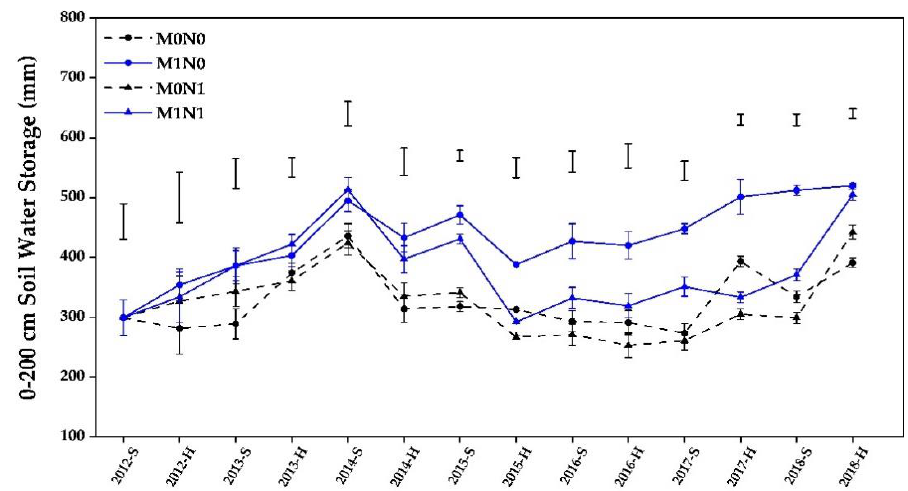
Figure 4. Soil water storage at a depth of 0–200 cm during the experimental period. M0N0—cultivation without film mulching and N application; M1N0—cultivation with film mulching but without N application; M0N1—cultivation without film mulching but with N application; M1N1—cultivation with film mulching and N application. Vertical bars above the curves are least significant difference (LSD) ( p = 0.05) of significant differences; vertical bars of each curve are the standard deviation.